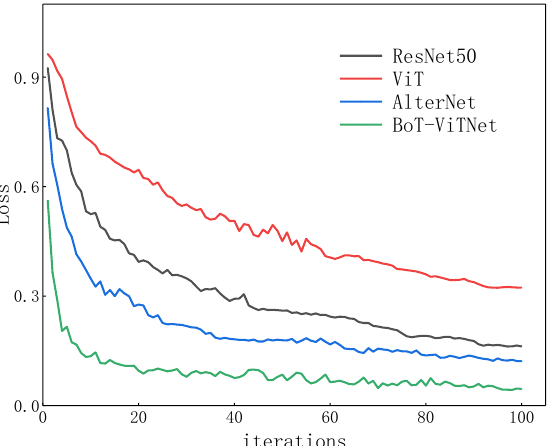
Figure 6. Loss variation curves of different models on the COVID-19 Radiography database.